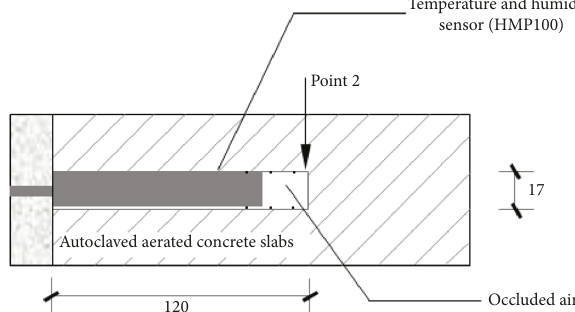
Figure 4: Installation method for sensors inside autoclaved aerated concrete slabs